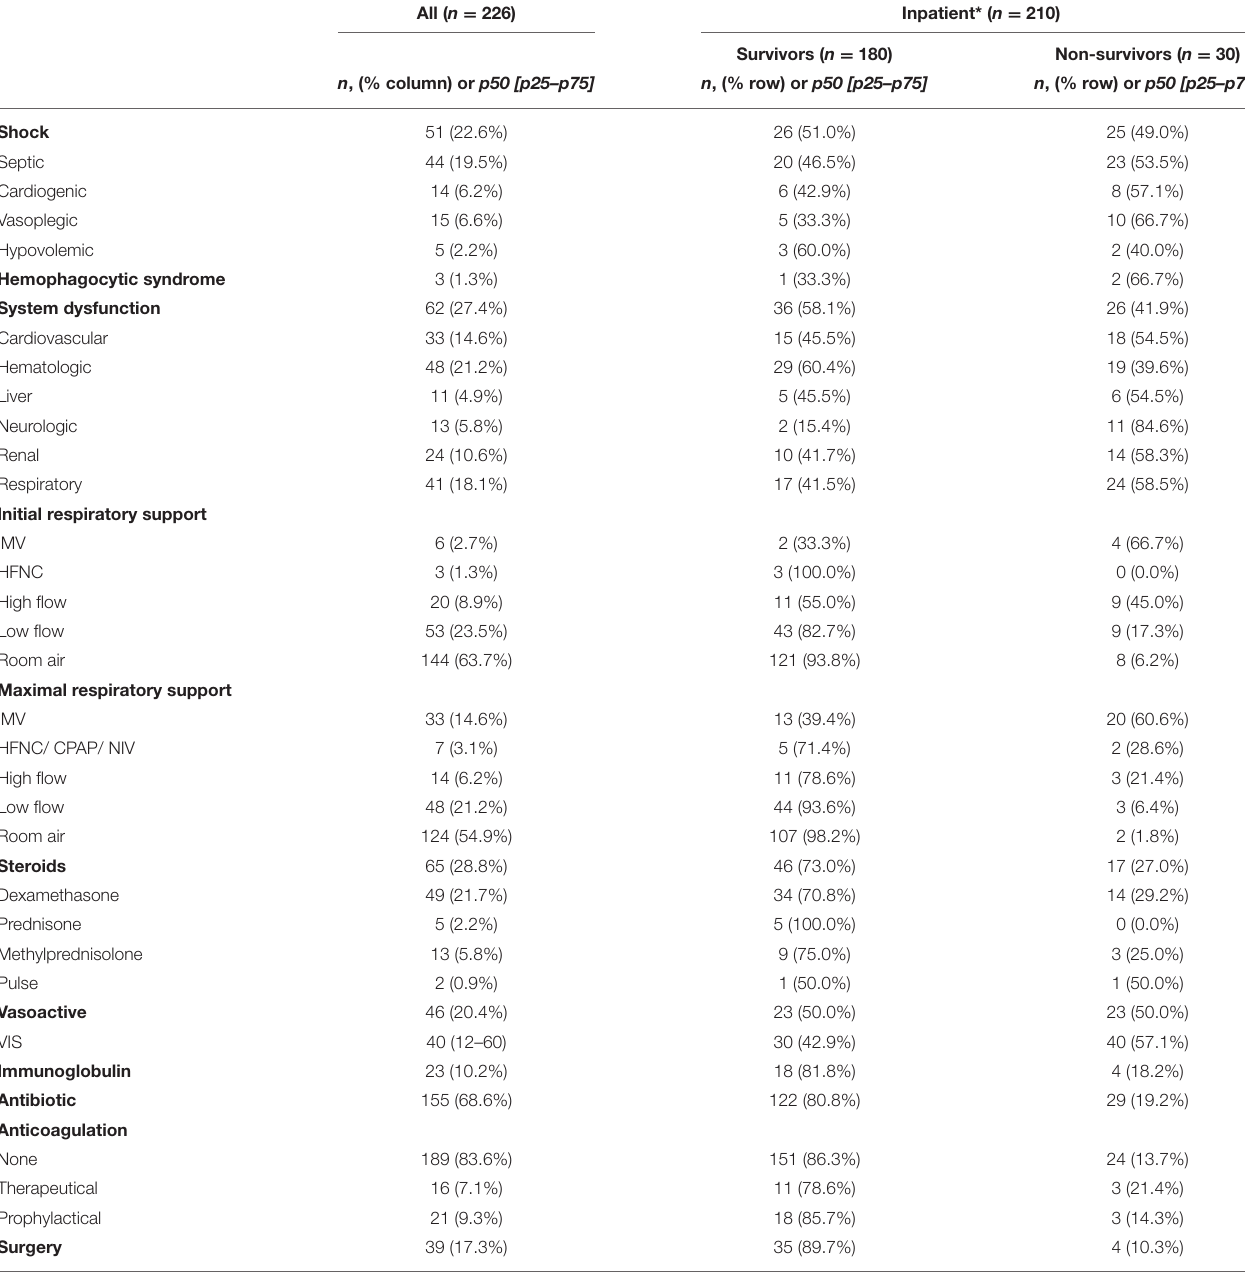
TABLE 4 | Critical presentation, and support